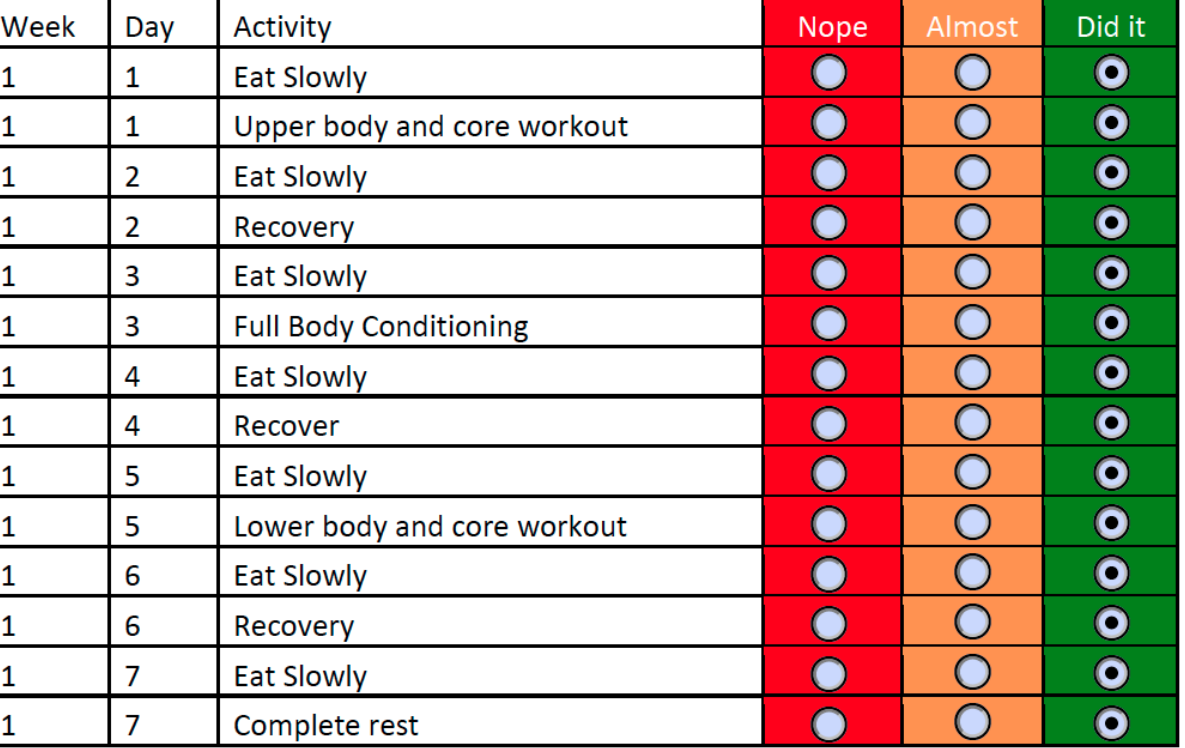
Figure 3. A sample of the logging table in the ePaper